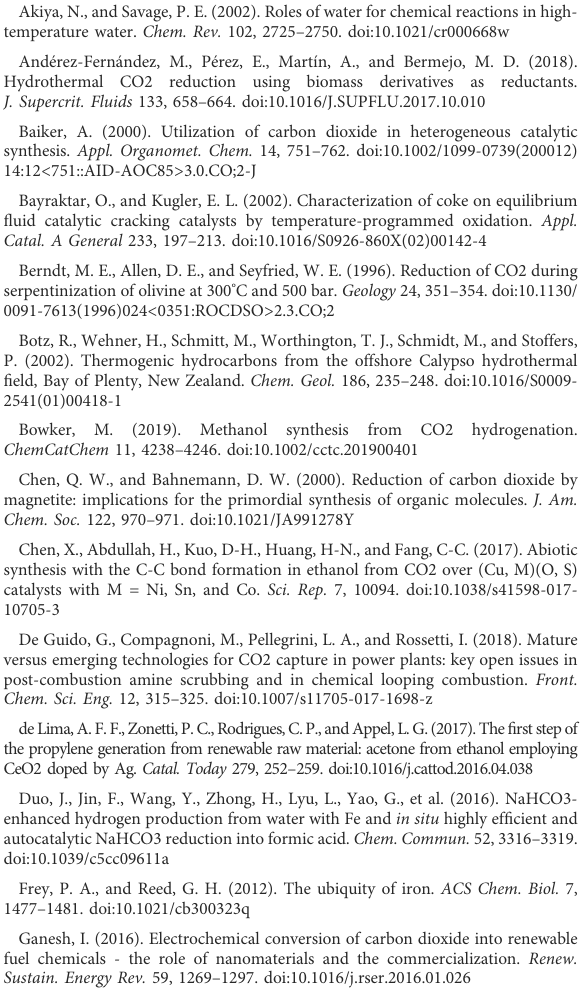
SUPPLEMENTARY TABLE S2 CO 2 conversion and gas phase composition at different CO 2 :air mole ratios. Reaction conditions: T=300 ° C; V H2O =7 mL; P CO2+air =25 barg; reaction time = 4 h; 0.56 g Fe. “ n.d. ” indicates that a species was